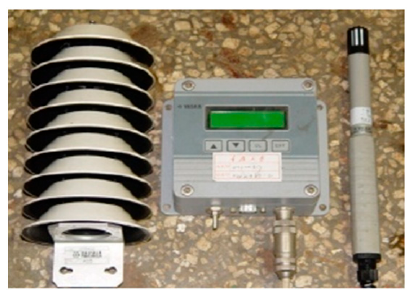
Figure 9. Temperature and humidity sensor.